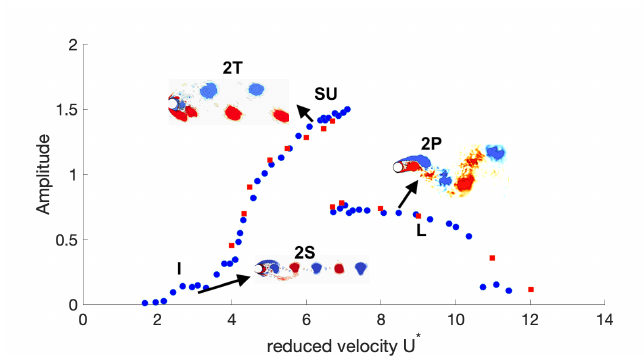
Figure 1. Wake topology depending on the reduced velocity for a 2 DoF cylinder with a low mass ratio. I—initial branch, SU—super-upper branch, and L—lower branch. 2S, 2T, and 2P are the wake topologies, as defined by Williamson and Roshko [15]. Data from (blue circles) Jauvtis and Williamson [17], (red squares) Pastrana et al.